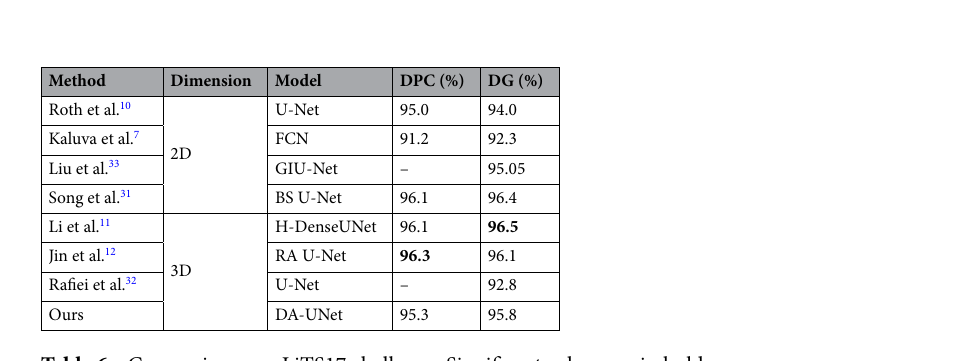
Table 6. Comparisons on LiTS17 challenge. Significant values are in